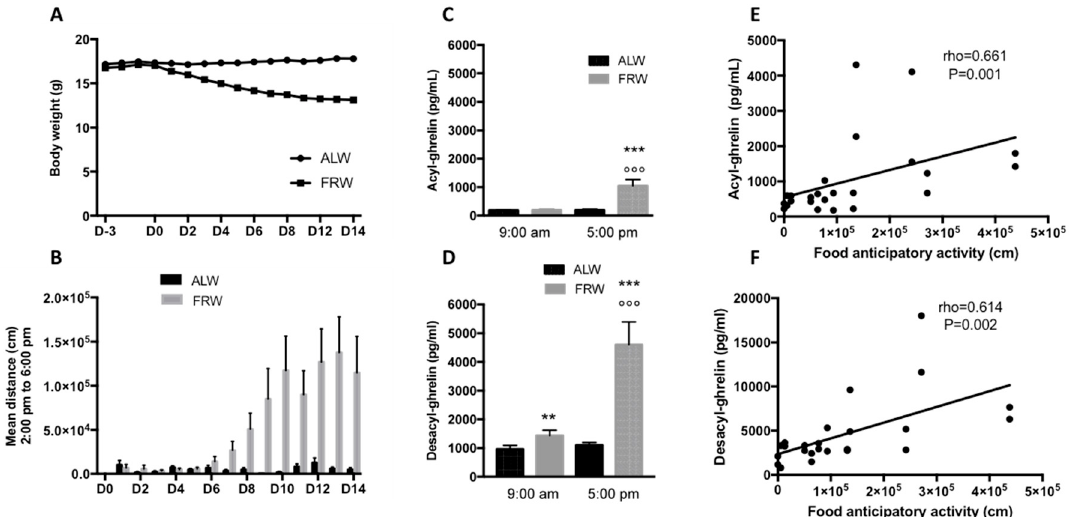
Figure 2. Short-term food restriction protocol. ( A ) Body weight evolution with a significant decrease from D2 to D14 for FRW vs. ALW mice. ( B ) Implementation of the food anticipatory activity (FAA, day activity) in the FRW mice from D6 to D14. ( C ) Mean plasma concentrations of acyl- (AG) and ( D ) desacyl-ghrelin (DAG) sampled at D10 (5:00 p.m.) and D11 (9:00 a.m.). Significant increases of AG and DAG were observed between morning and late afternoon samples only for FRW mice. ( E , F ) Plasma concentrations of AG ( E ) and DAG ( F ) were positively correlated with food anticipatory activity. Data are expressed as mean ± SEM; n = 24 / group. ◦◦◦ p < 0.001 9 h vs. 17 h; ** p < 0.01, *** p < 0.001 ALW vs. FRW. ALW: ad libitum and wheel; FRW: food restriction and